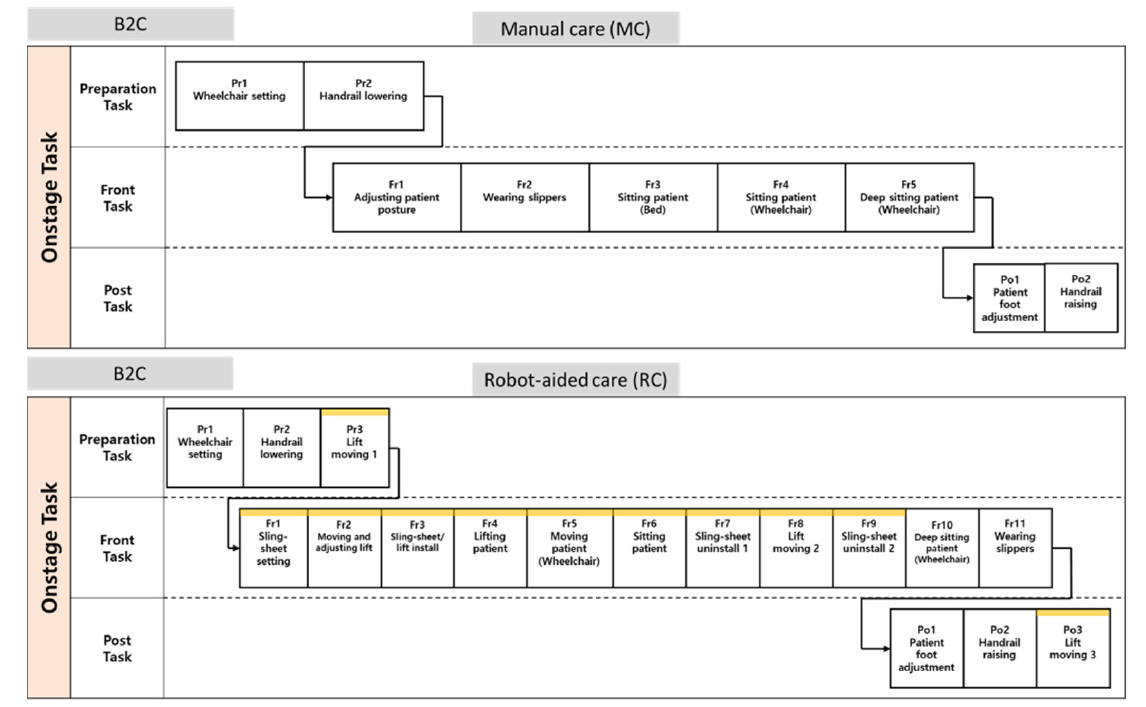
Figure 1. Structures of B2C sub-tasks for both MC and RC.